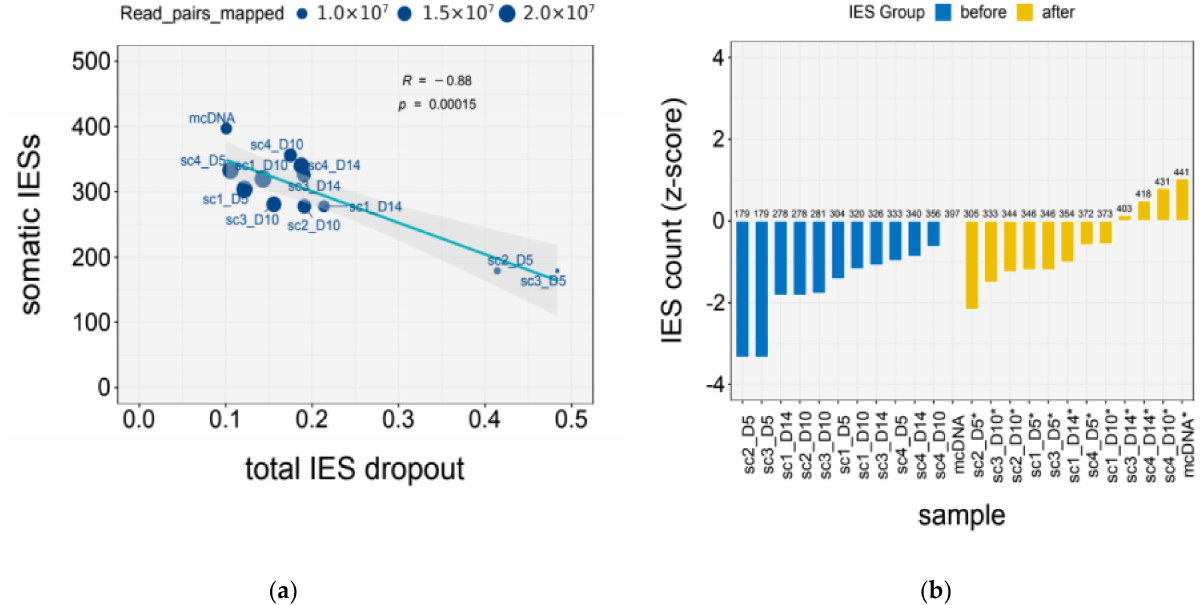
Figure 2. IES dropout due to uneven genome representation in scDNA samples. ( a ) Number of detected somatic IESs as a function of coverage. Number of somatic mutations detected as a function of Total IES dropout (“invisible” IES loci) and number of read pairs mapped (dot size). Somatic IESs ~ Total IES dropout, r = 0.882, p < 0.01.; ( b ) count of somatic IESs before and after correction. Somatic IES counts before and after correcting for Total IES dropout. Deviation is relative to the count obtained for bulk DNA-seq (mcDNA; z-score = 0). Correction, count/(1–Total IES dropout). Deviation from mcDNA count, IES count z-score = (IES_count–ref_value)/sd. Counts and corrected counts are indicated above bars. Sample names for corrected counts are labeled with a star